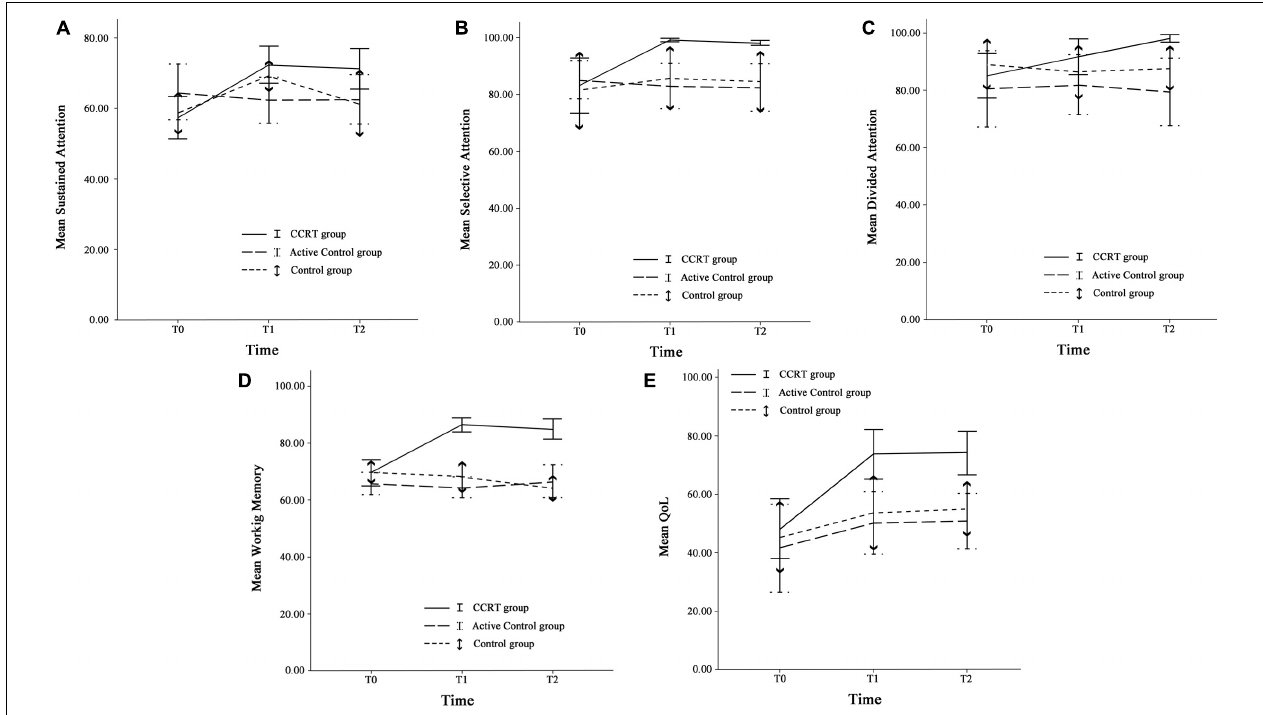
FIGURE 3 | Cognitive functions and QoL. (A) Sustained attention, (B) Selective attention, (C) Divided attention, (D) Working memory, and (E) QoL at three time points. Error bars represent 95% confidence interval (CI). T0 = pre-intervention (week 0); T1 = post-intervention (week 8); T2 = 6-month follow-up (week 32). TABLE 4 | Summary of pre/follow-up correlation between QoL improvement and cognitive functions enhancement. QoL improvement Cognitive functions Sustained attention Selective attention Divided attention Working memory ( n = 35) ( n = 35) ( n = 35) ( n = 35) Pearson’s r p -value Pearson’s r p -value Pearson’s r p -value Pearson’s r p